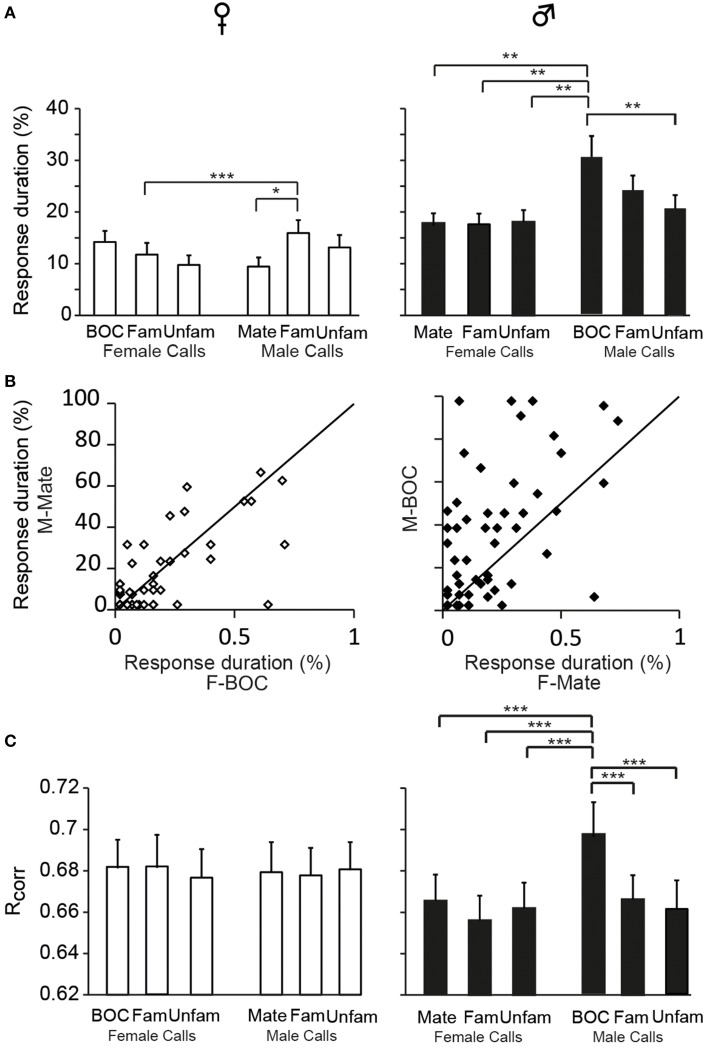
Sex differences in the temporal features of call-evoked responses. (A) Duration of responses to the variety of call stimuli in females (left) and in males (right). Based on PSTHs built from spike trains, the number of 10 ms bins in which activity exceeds the baseline level by 2 SD is quantified and expressed as a percentage of the total duration of the call presented. In males, the bird's own call, which is the mate's call in females, induces longer responses than most other call stimuli (*p < 0.05; **p < 0.01). (B) Within-cell comparisons of the duration of responses to the calls of the two partners: the mate's call and the bird's own call. The same set of stimuli was presented to both partners. Each dot represents a single cell. The diagonal line represents equal responsiveness to both stimuli. Points to the left of the diagonal line are biased toward the male's call while points to the right are biased toward the female's call. In males, a majority of cells show longer responses to the male's call than to the female's call. (C) The computed correlation index between spike trains (Rcorr) elicited by repetitions of the same stimulus does not differ between call stimuli in females. In males, the bird's own call yields a higher average Rcorr value than all other call stimuli (***p < 0.001 in all cases). Each bar represents the mean ± SEM.